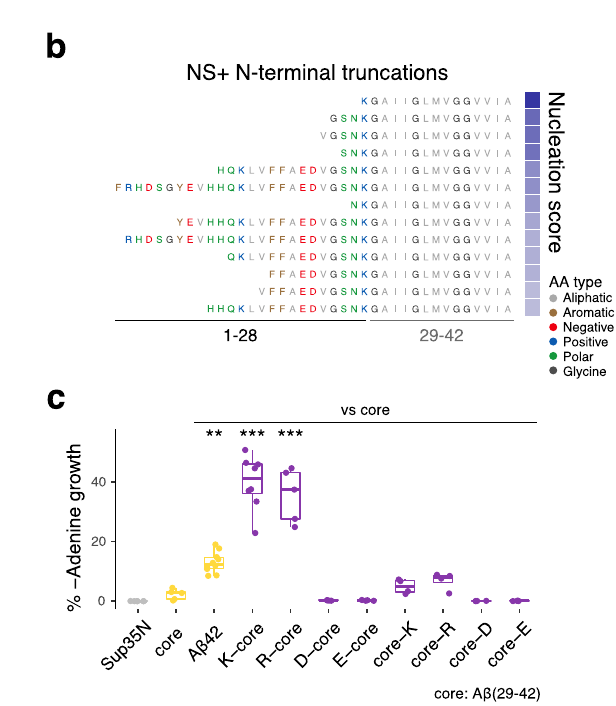
Fig. 4 | Positive charge accelerates nucleation of a minimal A β core. a Effect of N-terminal (top) and C-terminal (bottom) truncations on nucleation ( n =3 biolo- gical replicates). Vertical error bars indicate 95% con fi dence interval of the mean NS. b AAsequencesofN-terminaltruncationsthatincreasenucleationatFDR=0.1. AAarecoloredbyclass. c Effectofaddingapositivelyornegativelychargedresidue at the N or C-terminus of the A β core (AA 29 – 42). Nucleation quanti fi ed as per- centage of colonies in medium lacking adenine vs. medium containing adenine